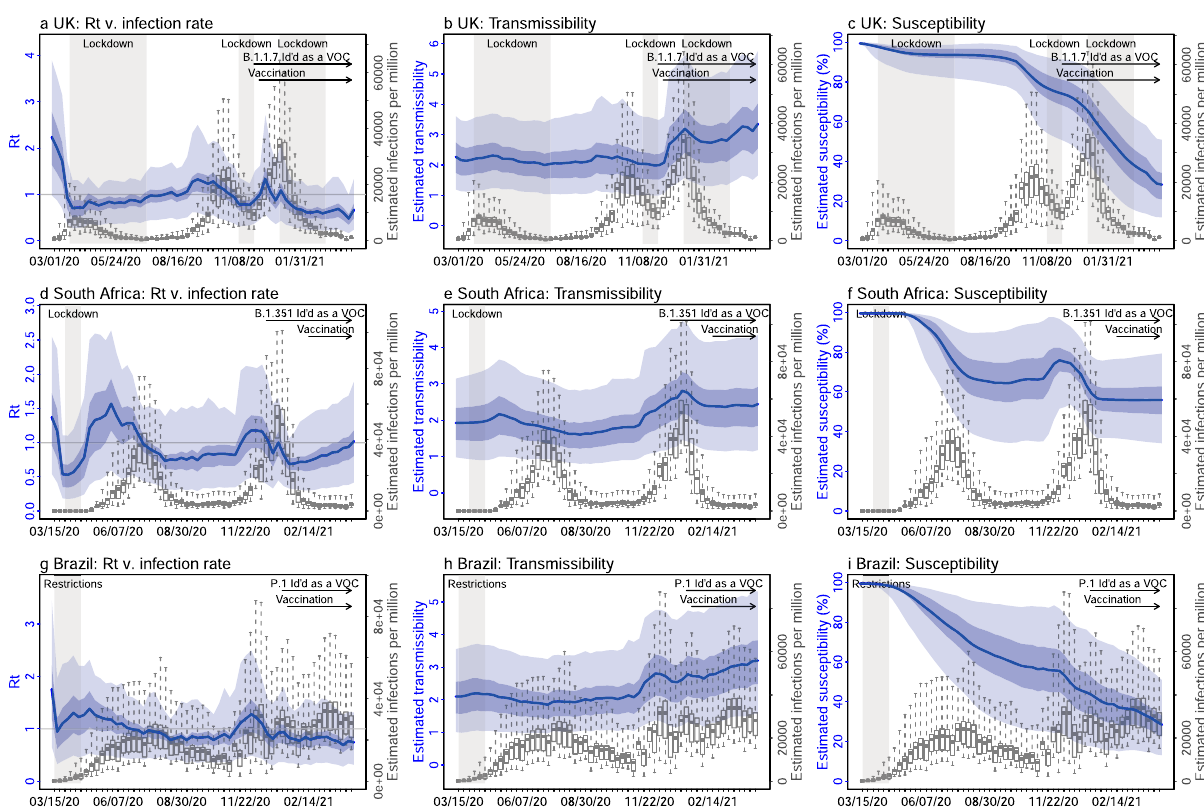
Fig. 3 Key model-inference system estimates. Left column ( a , d , g ) shows estimated real-time reproduction number R t , middle column ( b , e , h ) shows estimated transmissibility, and right column ( c , f , i ) shows estimated population susceptibility for each week during the study period, for the three countries. For comparison, estimated weekly infection rates are superimposed in each plot (right y axis). Blue lines and surrounding areas show the estimated mean, 50% (dark) and 95% (light) CrIs. Boxes (middle bar = mean; edges = 50% CrIs) and whiskers ( = 95% CrIs) show the estimated weekly infection rates. Gray shaded areas indicate the timing of lockdowns or key periods of restricted activity; horizontal arrows indicate the timing of variant identi fi cation and vaccination rollout. Note that the transmissibility estimates ( b , e , h ) have removed the effects of changing population susceptibility, NPIs, and disease seasonality; thus, the trends are more stable than the reproduction number ( R t ; a , d , g ) and re fl ect changes in variant-speci fi c properties. Model estimates (mean, 50% and 95% CrIs) are summarized over n = 100 model-inference runs (500 model replica each, totaling 50,000 model